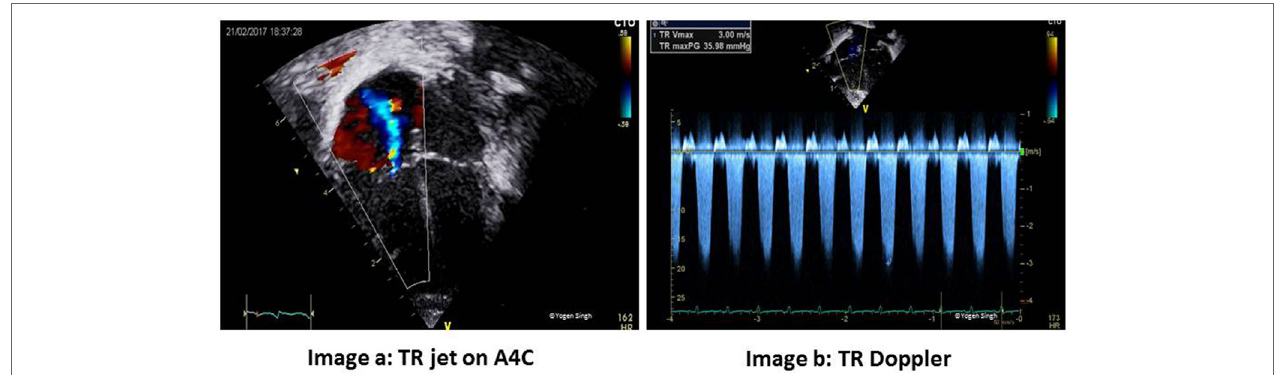
FiGURe 6 | Estimation of pulmonary artery systolic pressure (PASP). Image a shows tricuspid regurgitation (TR) jet in apical four-chamber view (A4C) and image b with Doppler assessment of TR—in this case a gradient of around 36 mmHg between right ventricle and right atrium (RA) suggests PASP between 40 and 45 mmHg (36 + RA pressure of 5–10